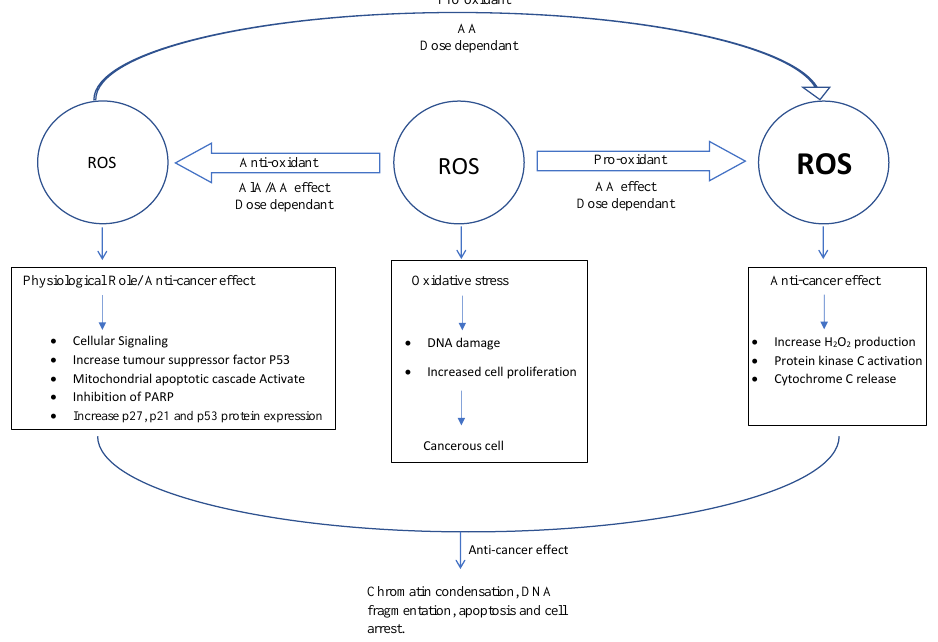
Figure 2. Schematic illustration for antioxidant (AA: ascorbic acid; ALA: alpha lipoic acid) e ff ects on reactive oxygen species (ROS) and / or mechanism of action in cancer